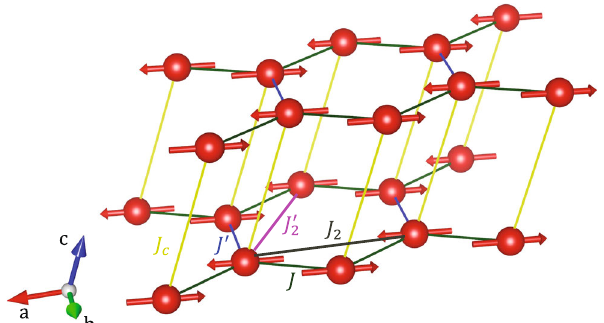
Fig. 1 Crystal and magnetic structure of YbCl 3 . The monoclinic crystal structure (space group C 12/ m 1) and ordered spin con fi guration (magnetic space group C 2 0 = m ) of YbCl 3 . The monoclinic structure with a = 6.729 Å , b = 11.614 Å , c = 6.313 Å , and β = 110.6° (at T = 10 K) contains nearly ideal honeycomb lattices of Yb 3 + ions (red spheres) 61 . Within each honeycomb lattice, the Yb 3 + sites have nearest-neighbor distances of 3.884 Å and 3.867 Å for the exchanges J and J 0 , respectively, and next-nearest-neighbor distances of 6.729 Å and 6.711 Å for the exchanges J 2 and J 0 , respectively. 2 The resulting three bond angles for the honeycomb lattice are 120°, 119.97°, and 119.97°. The distance between the honeycomb planes is 6.313 Å , corresponding to an interlayer exchange J c . For the ideal model (see Eq. ¼ J ¼ 0. The spins are (1)), we consider J ¼ J 0 and J 2 ¼ J 0 c 2 antiferromagnetically aligned within each honeycomb plane and point primarily along the a axis with a small tilt of 5(3)° along the c axis, as described in the